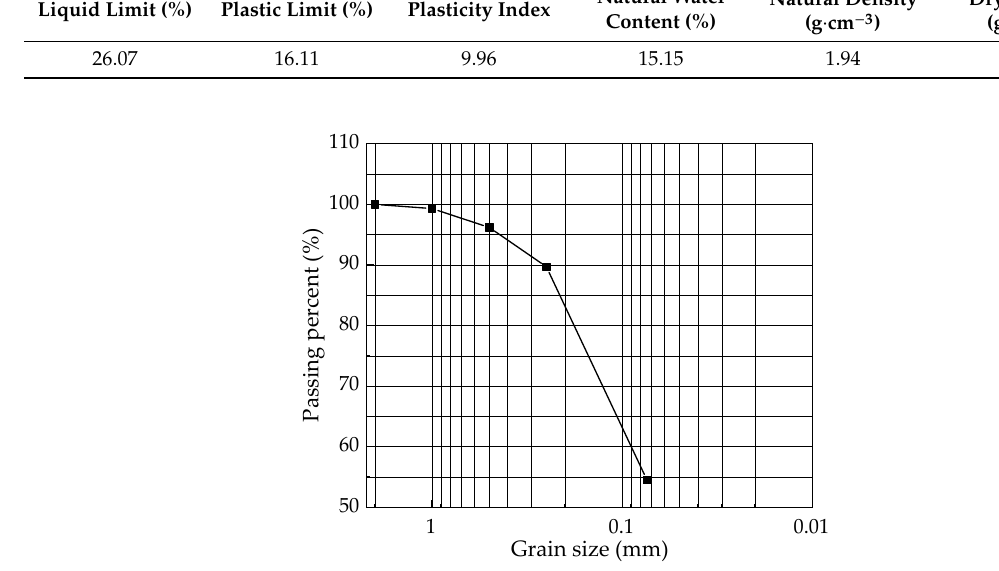
Figure 2. Particle size distribution in silty soil from the Yellow River flood area in Henan, China.